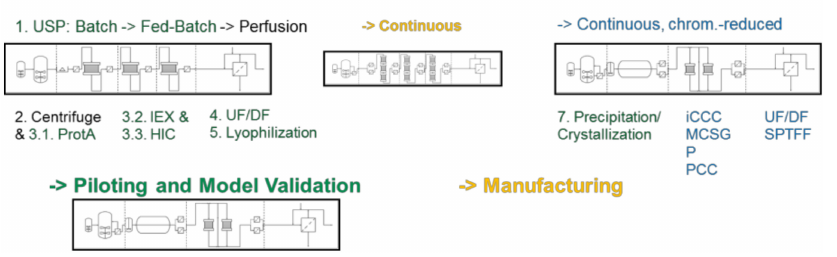
Figure 3. Total process modeling—a digital twin for regulatory